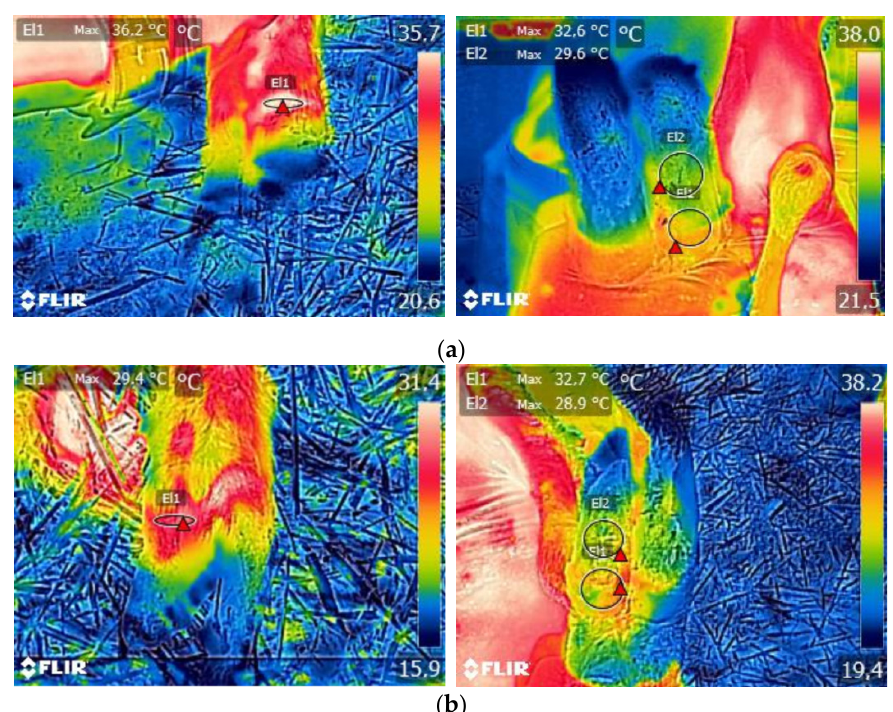
Figure 3. Maximum temperature measurements at the coronary band (T1 = El1), the hoof sole (T2 = El1), and the hoof heel (T3 = El2) in animals with ( a ) footrot and ( b ) white line disease lesions.